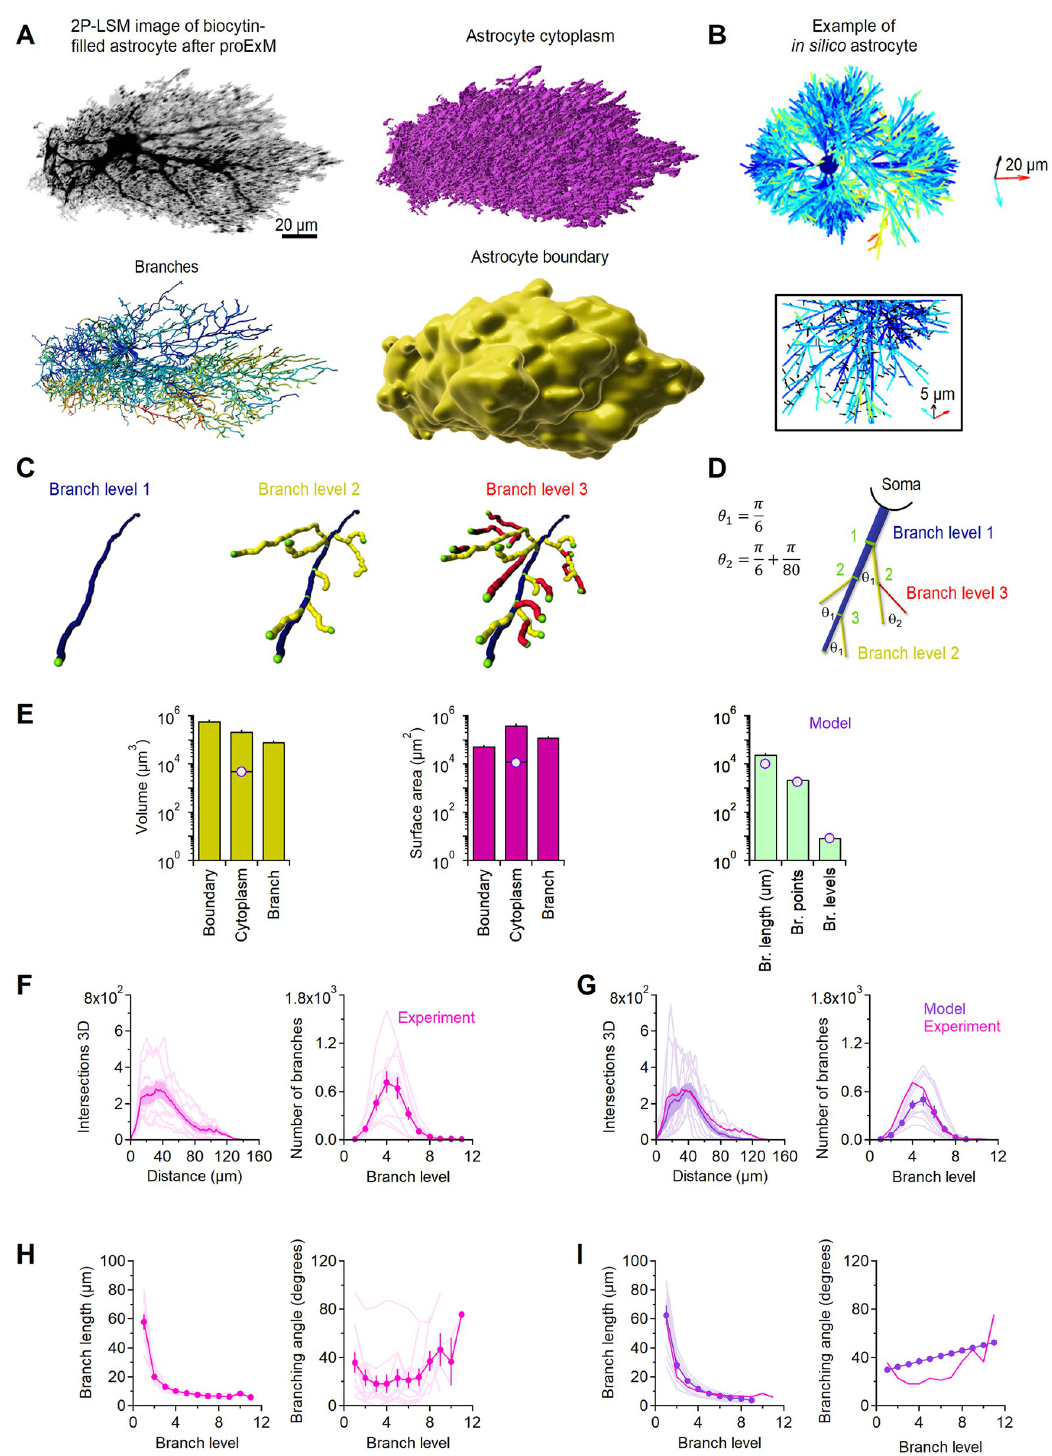
Fig 4. Astrocyte morphology in stratum radiatum of the mouse hippocampus. A . Top left , Maximum intensity projection of a 2P-LSM z-stack of a biocytin-filled astrocyte in a mouse hippocampal stratum radiatum . Top right , Image analysis of astrocytic branches. Higher branching levels are denoted by warmer colors. Bottom left , Image analysis of astrocyte cytoplasm. Bottom right , Volume of the hippocampal neuropil occupied by the astrocyte. B . Top, In silico representation of an astrocyte generated through our MATLAB model. The color scheme for each branch level is the same used for the reconstructions of biocytin-filled